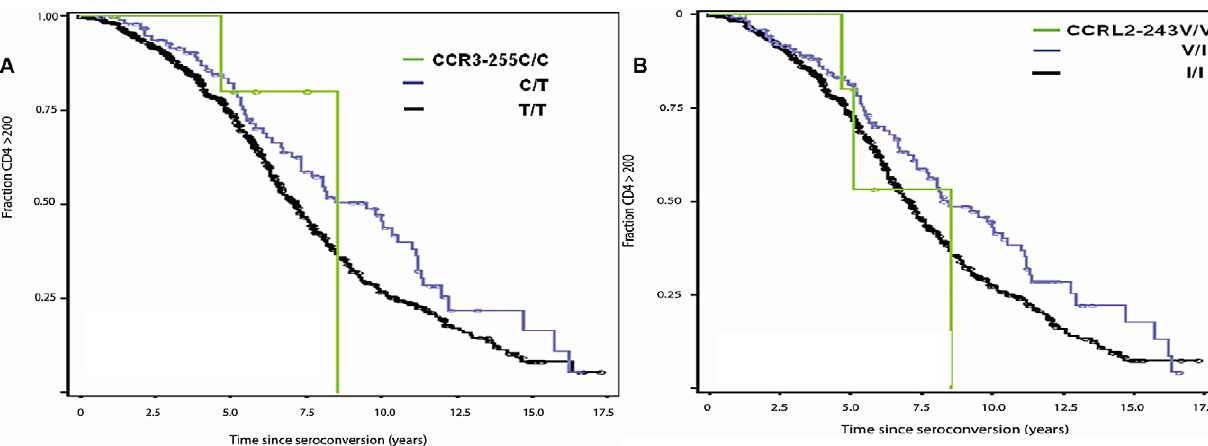
Figure 2. Genetic effect of CCR3 -255C and CCRL2 -243V on AIDS progression. Kaplan-Meier survival curves of time progression since HIV-1 infection to AIDS (1987 CDC definition) were plotted for genotypes of CCR3 -255C (A) and CCRL2 -243V (B). Circles on the curves indicate those censored.